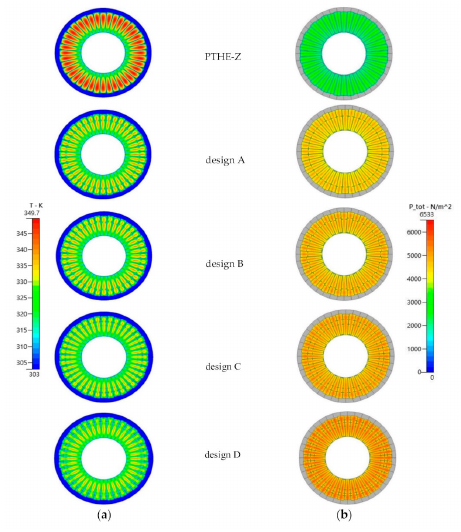
Figure 10. The comparisons of cross-sectional view of ( a ) temperature and ( b ) pressure distributions for various designs at z = 100 mm.